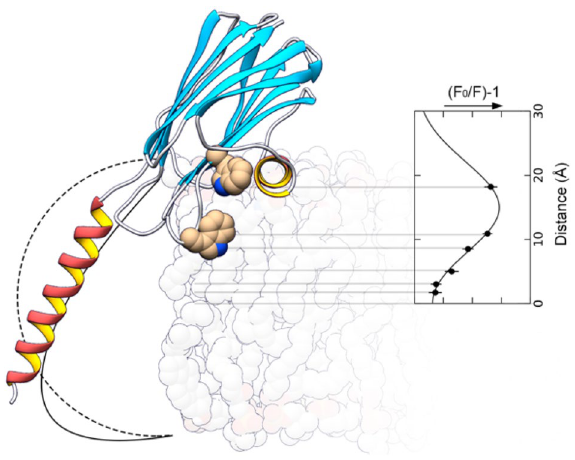
Figure 5. Position of the Trp residues of Stns within the membrane. The structure of StnI (PDB ID 2KS4), modified to present the N-terminal α-helix extended, showing W111 and W115 (W110 and W114 in StnII) in their expected position relative to the membrane normal, according to present results (insert on the right). The angle with the α-helix with the membrane normal is ~ 32º, according to 29,86 . The dashed line indicates the membrane shape in an ideal torus. Solid line is the suggestion of what the shape of the membrane limit (not necessarily the polar surface) could be in these pores. It seems unlikely that lipid headgroups could reside on the part of the line that is behind the α-helix. To see this figure in color, go